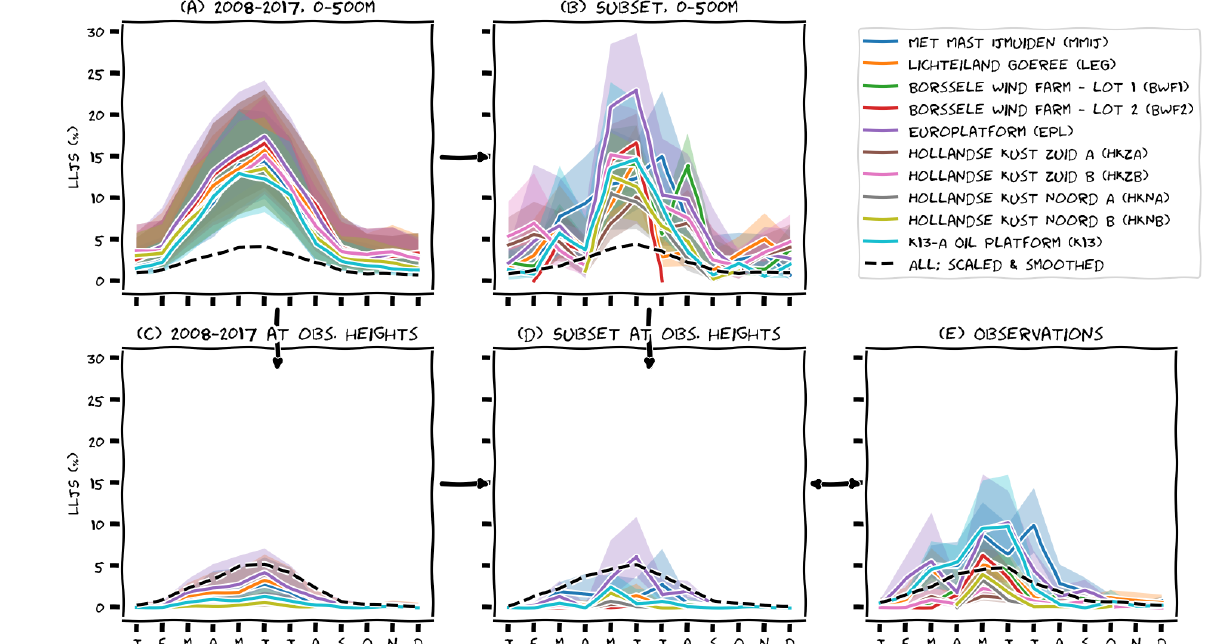
Figure 6. Seasonal cycle for various representations of model data and observations. Shading is the sensitivity to ± 0 . 5ms − 1 for the LLJ fall-off threshold. The dashed lines represents an aggregated seasonal cycle of all platforms, smoothed with a rolling average of 3 months (2 at the edges) and scaled with the ratio of the mean jet frequency in the respective representations of ERA5 and the mean jet frequency in the